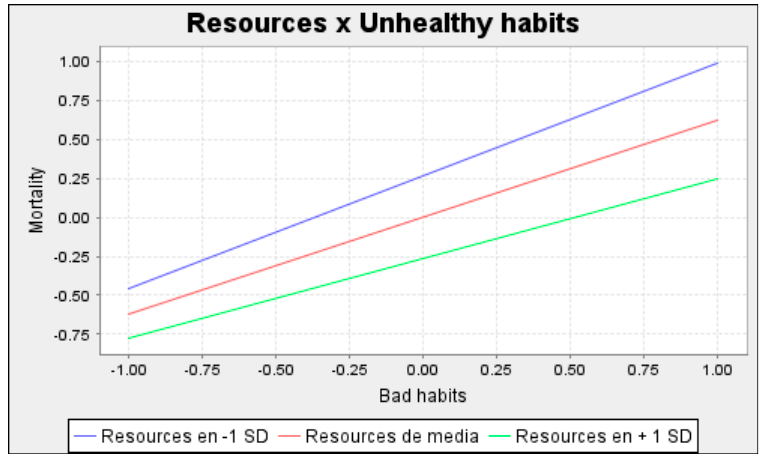
Figure 5. The moderating effect of resources on the relationship between unhealthy habits and mortality.